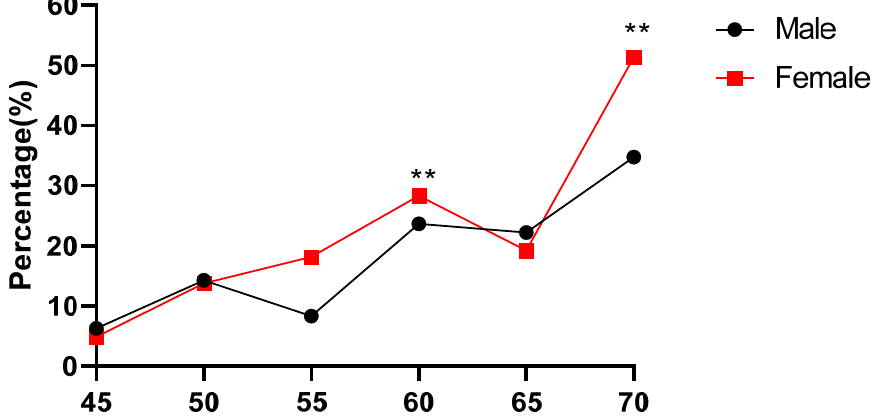
Figure 2. Trends of percentage changes with age in individuals with bone loss among middle-aged and elderly Mulam people. (Comparison of prevalence rates between male and female of the same age group, ** p < 0.01).